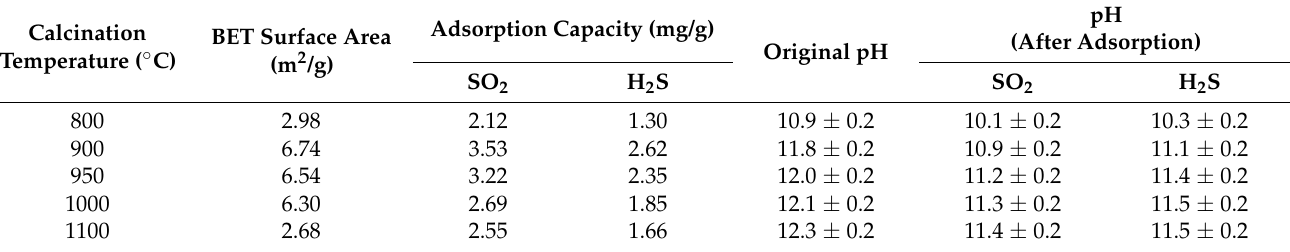
Table 5. Adsorption capacity and pH of calcined eggshell at different